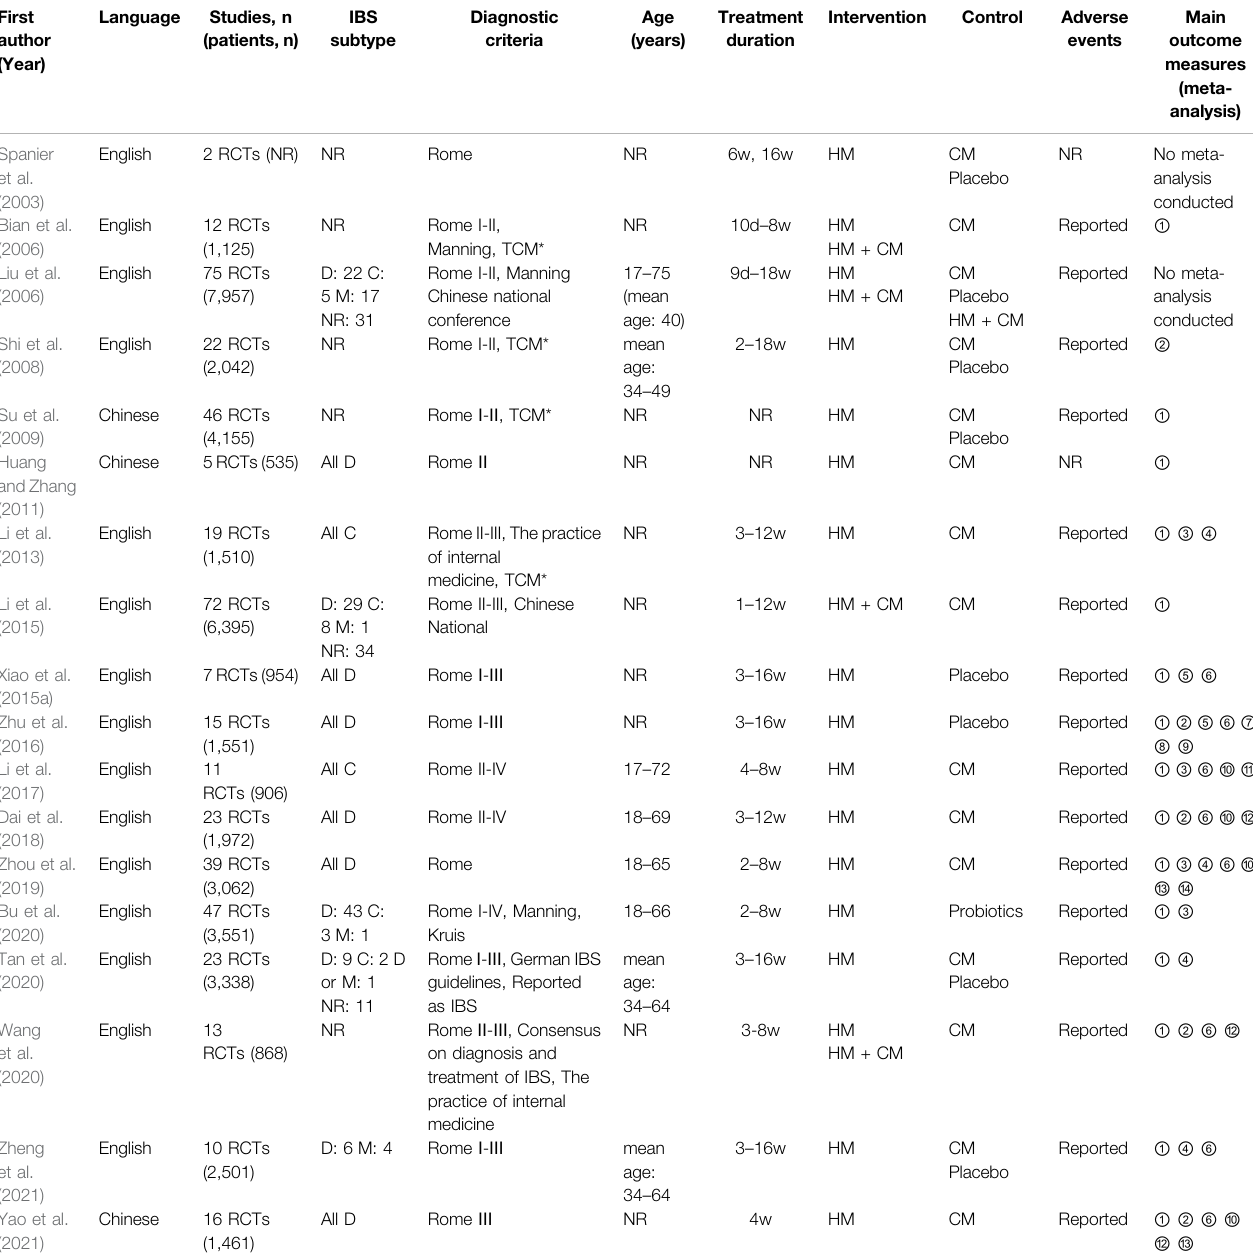
TABLE 2 | Main characteristics of included